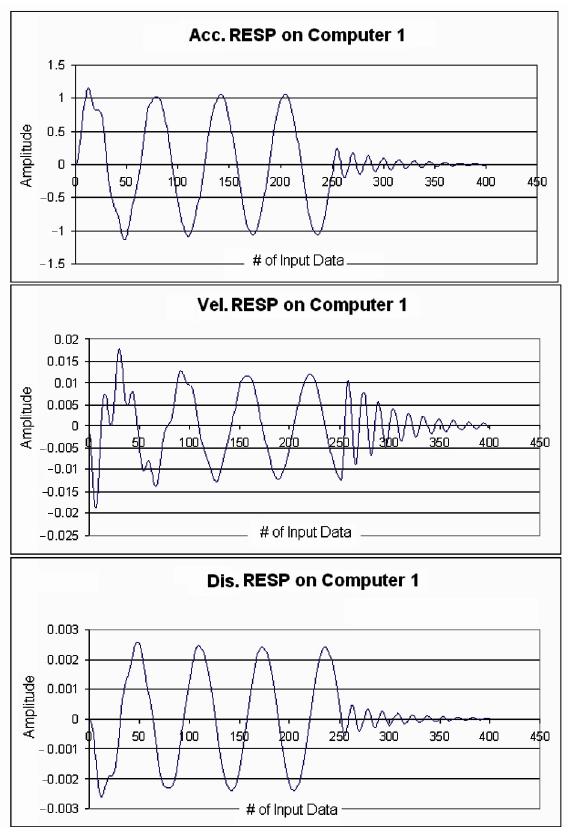
Fig. 7. Response of SDOF Structure from Parallel Program